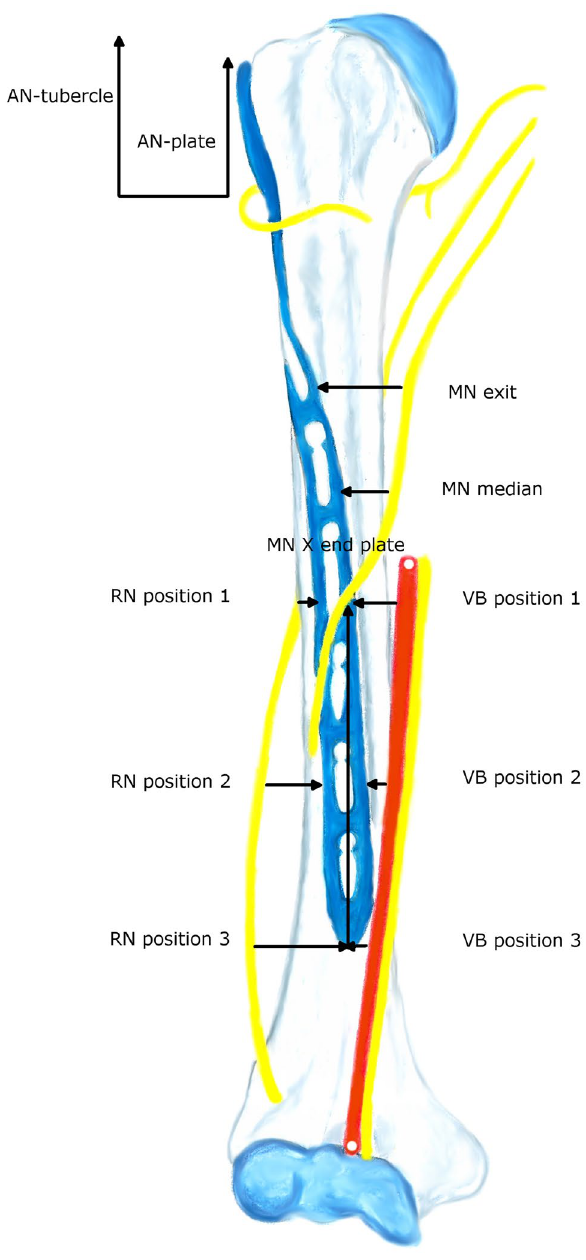
Figure 4. Measurement pattern. AN-plate AN to proximal margin of the plate, AN-tubercle AN to tip of greater tubercle, VB medial vascular bundle for respective position, MN exit exit of MN from coracobrachialis, MN X end plate intersection point of the MN and the plate measured from the distal margin of the plate, MN median measurement point at the middle of the exit and intersection